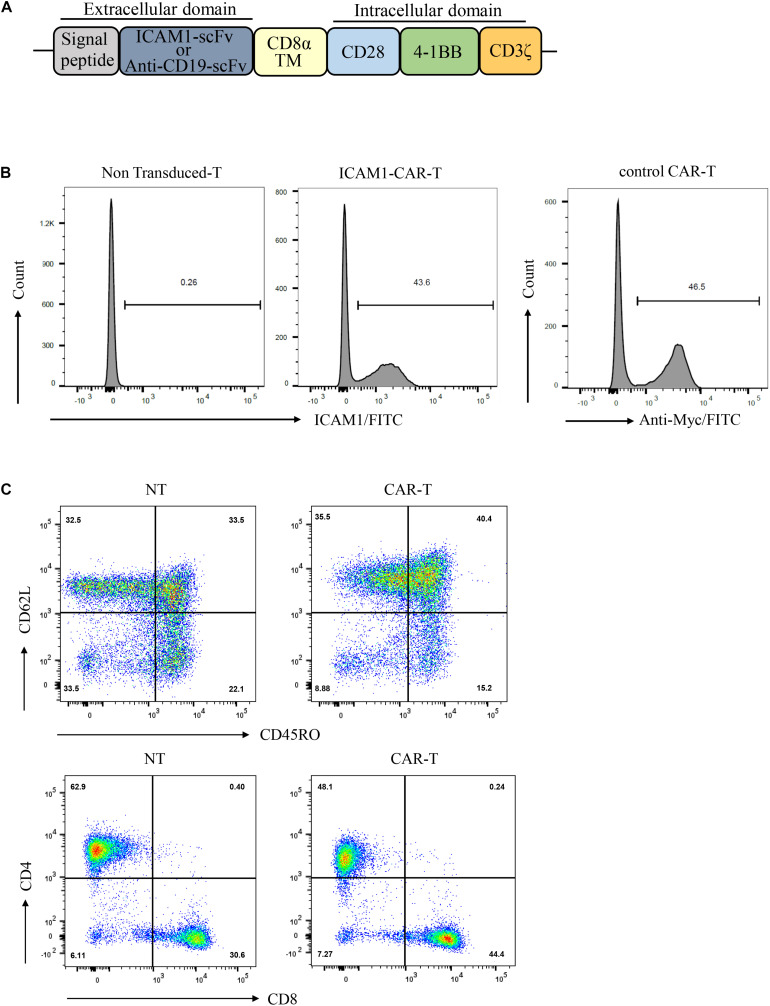
Production of ICAM1-specific CAR-T Cells. (A) Schematic representation of the ICAM1-specific CAR and control CAR (anti-CD19 CAR) constructs containing the following fragments: mG2-scFv/anti-CD19-scFv; CD8α transmembrane domain; intracellular signaling domains of CD28, 4-1BB, and CD3-ζ. (B) The ICAM1-CAR and CD19-CAR expressing human T cells were stained with antigen and then detected by FACS. (C) Ten days after lentivirus CAR transduction, the subsets and phenotypes of NT and ICAM1-specific CAR-T cells were analyzed by FACS, including the expression of CD4, CD8, CD45RO, and CD62L.